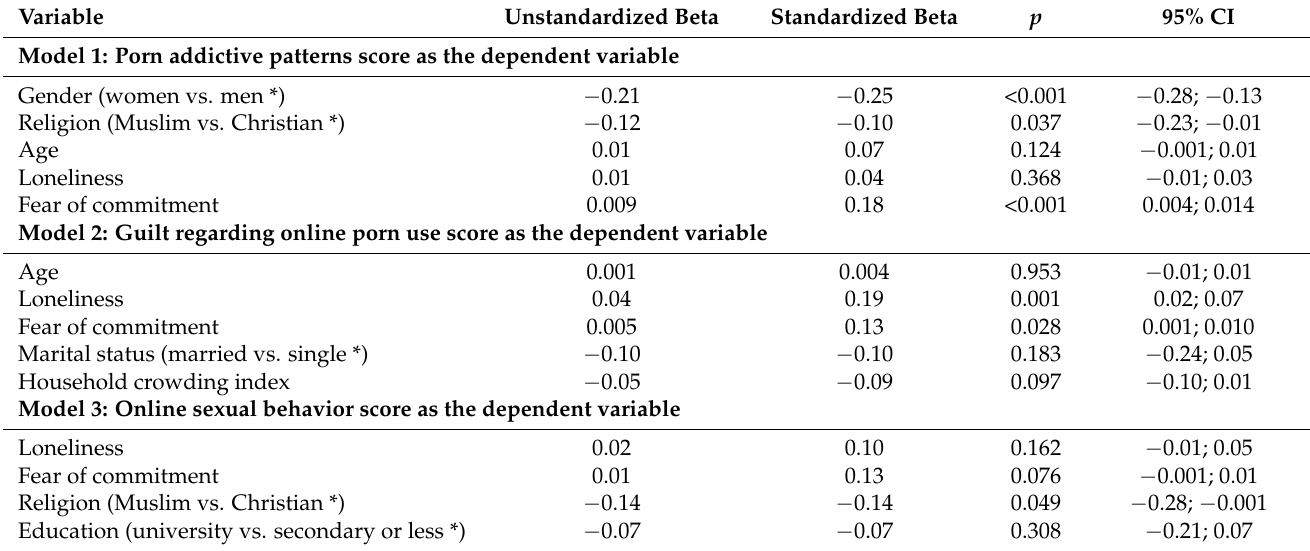
Table 4. Linear regressions models taking the porn addictive patterns, guilt regarding online porn use, and online sexual behavior scores as dependent